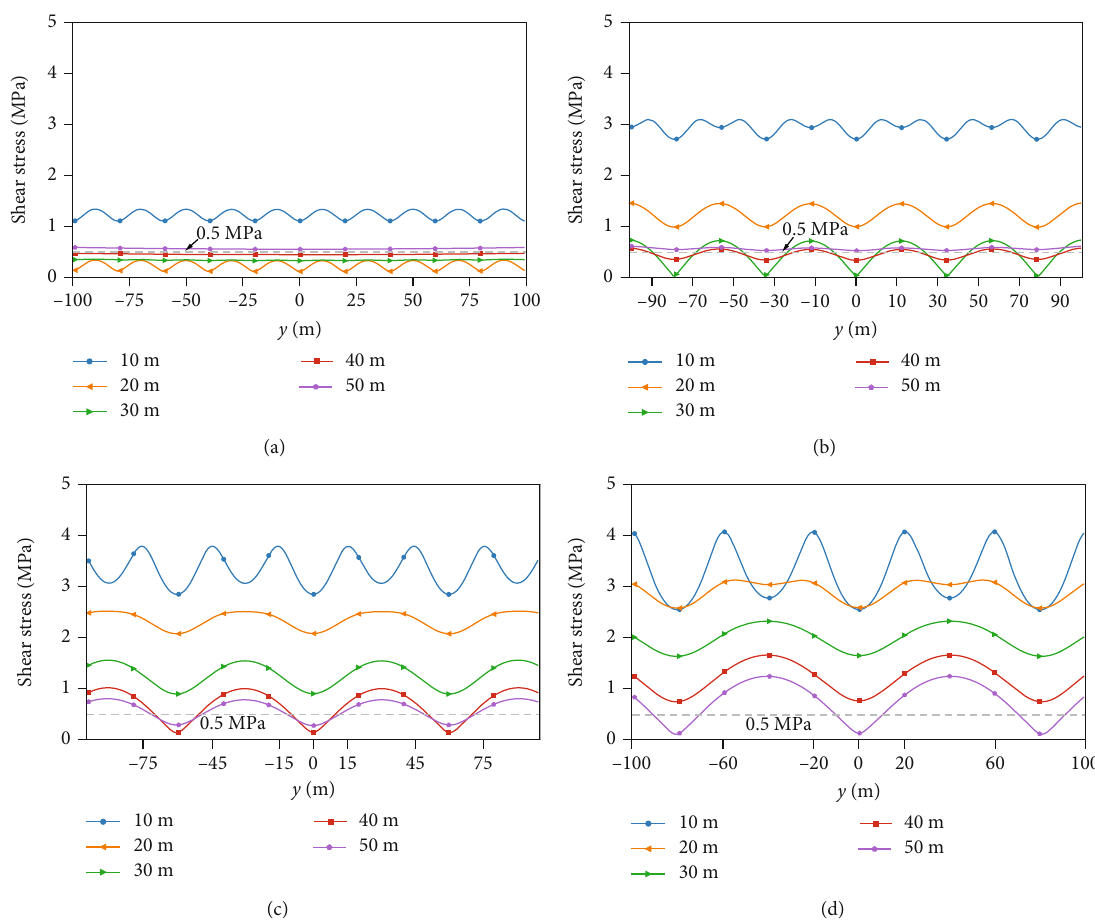
Figure 8: Shear stress distributions at various depths: (a) width of excavated coal pillar is 10m, (b) width of excavated coal pillar is 20 m, (c) width of excavated coal pillar is 30m, and (d) width of excavated coal pillar is